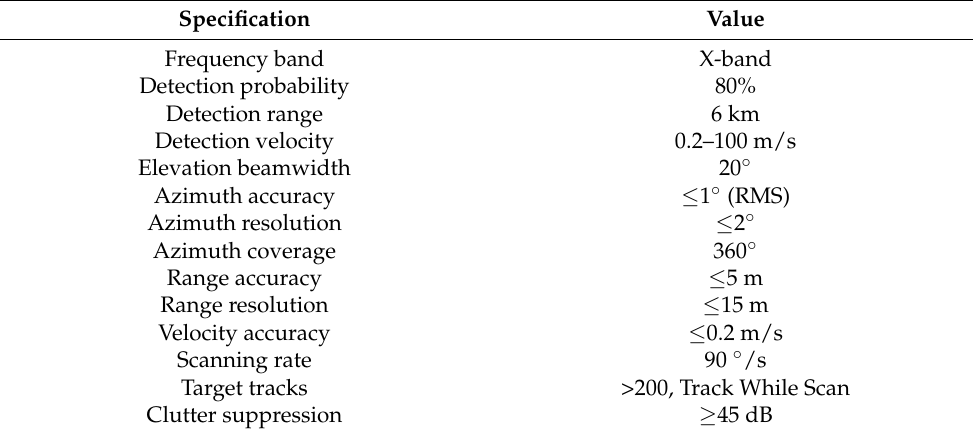
Table 6. Doruk radar